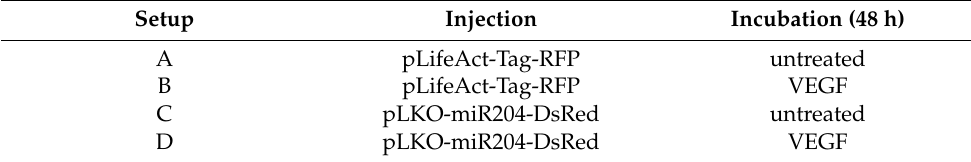
Table 2. Overview of experimental groups for microinjection. PC of age groups 2 and 3 were assigned to all experimental setups A–D. All injections were performed simultaneously with pEGFP-C1. Setup Injection Incubation (48 h) A pLifeAct-Tag-RFP untreated B pLifeAct-Tag-RFP VEGF C pLKO-miR204-DsRed untreated D pLKO-miR204-DsRed